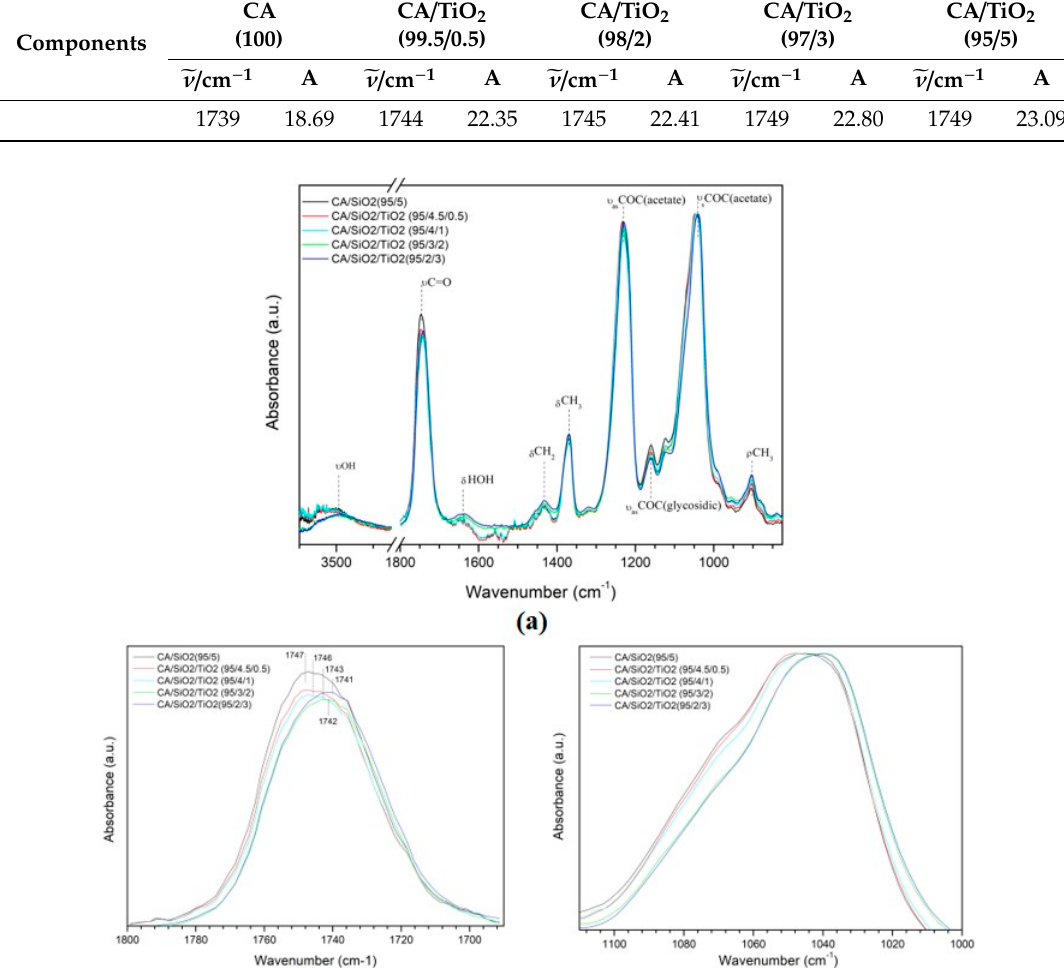
Table 7. Areas and wavenumbers of the carbonyl group located in the 1690–1800 cm − 1 region for the CA / TiO 2 membranes.